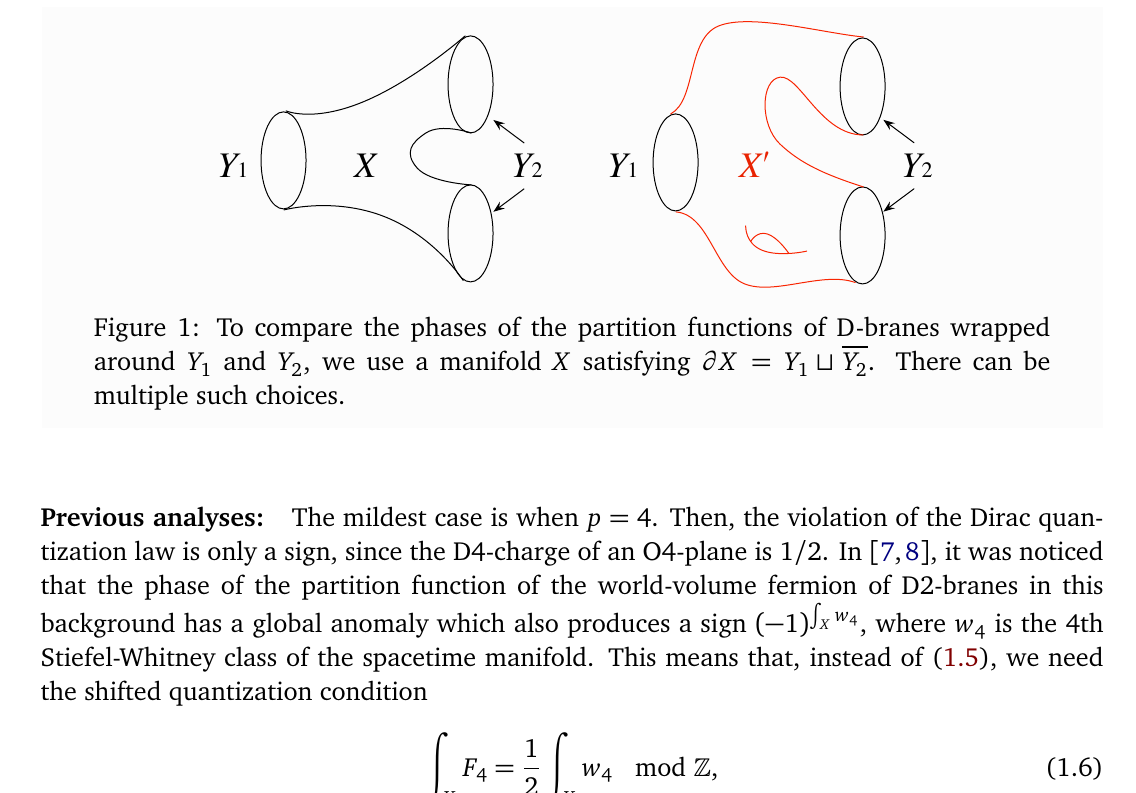
(cid:116) Y . There can be 1 2